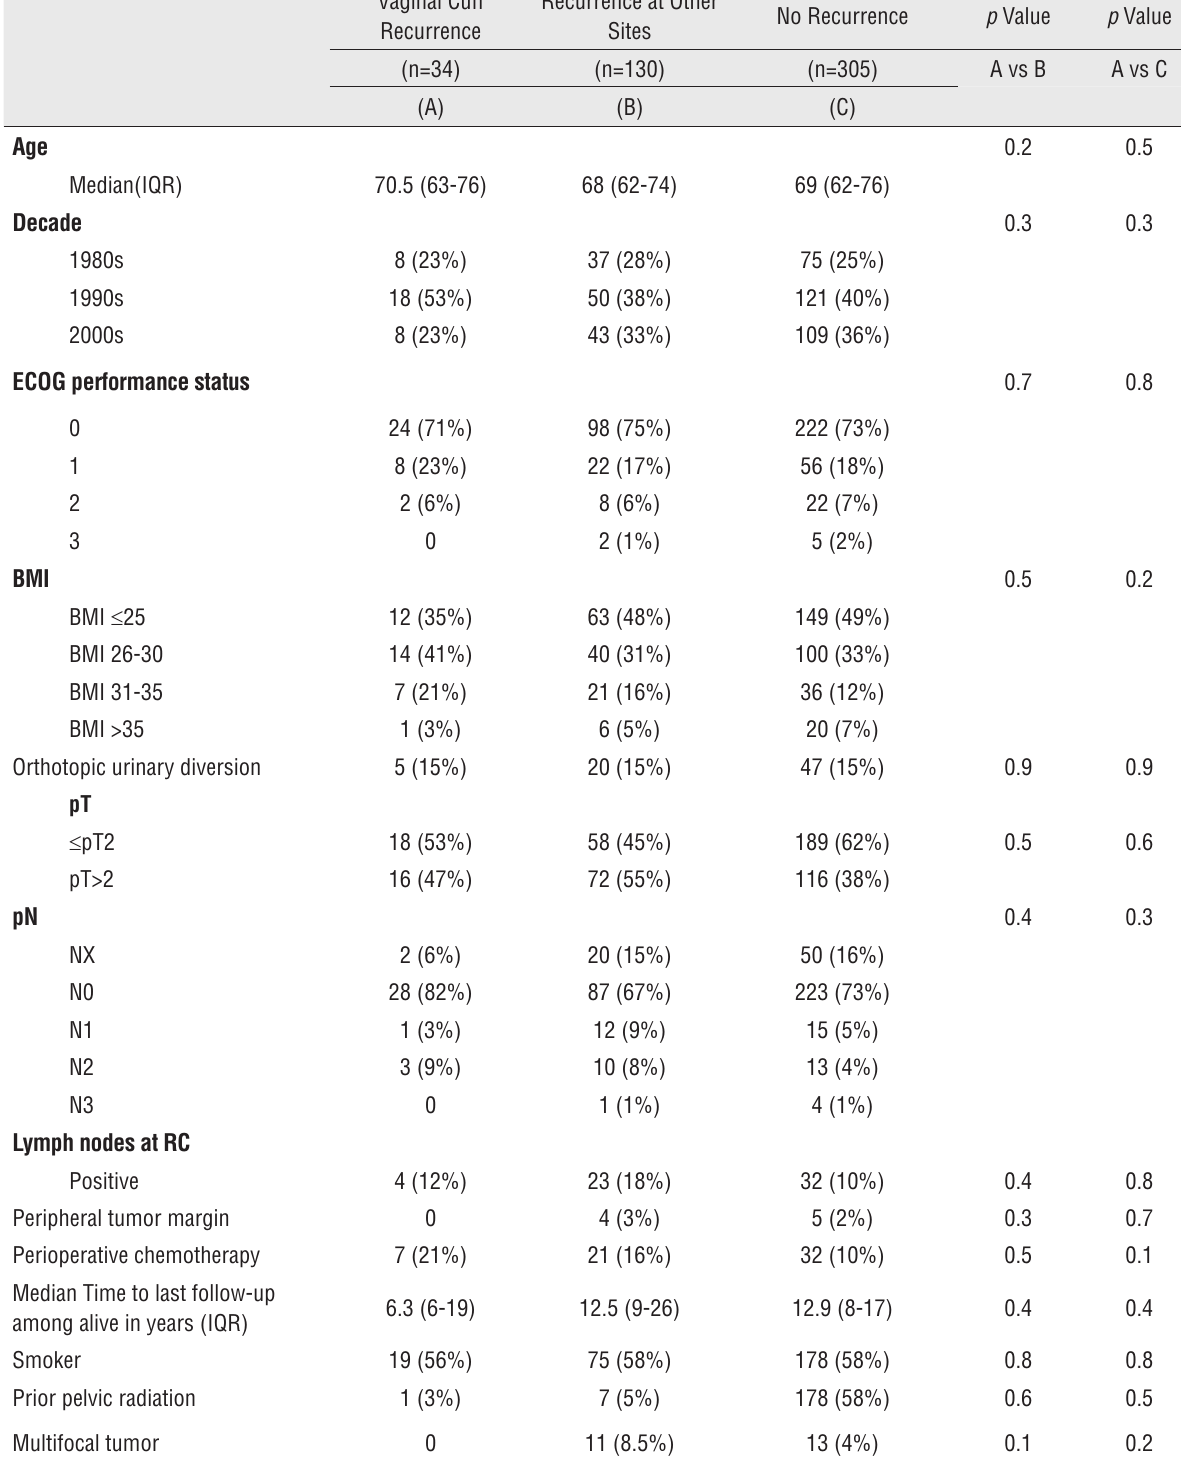
Table 1 - Distribution of Risk factors Among vaginal cuff Recurrence (A) vs. Recurrence at Other Sites (B) vs. No Recurrence